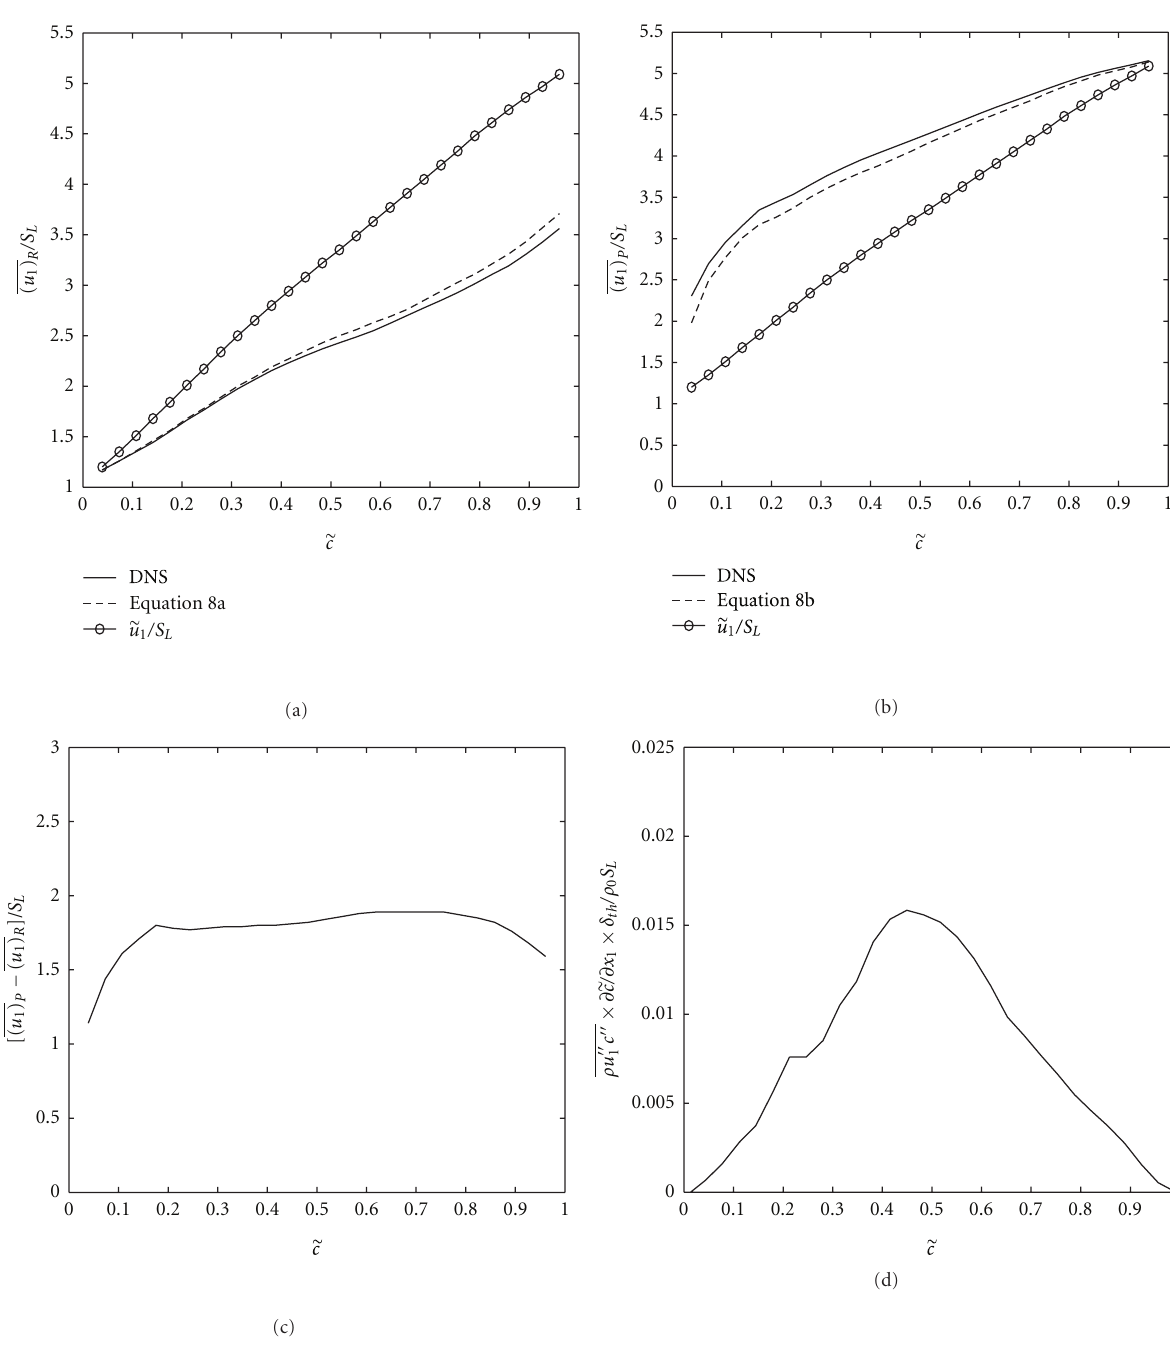
and (cid:2) u 1 /S L with (cid:2) c across the flame brush along with the predictions of (8a). (b) Variations ( u 1 ) R /S L